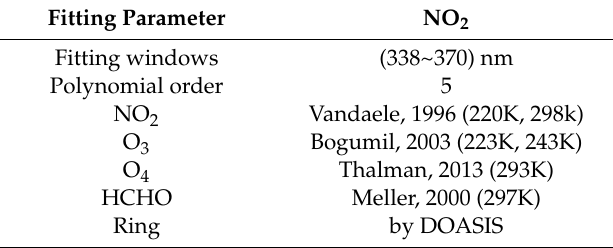
Table 1. NO 2 slant column density (SCD) retrieval fit setting.